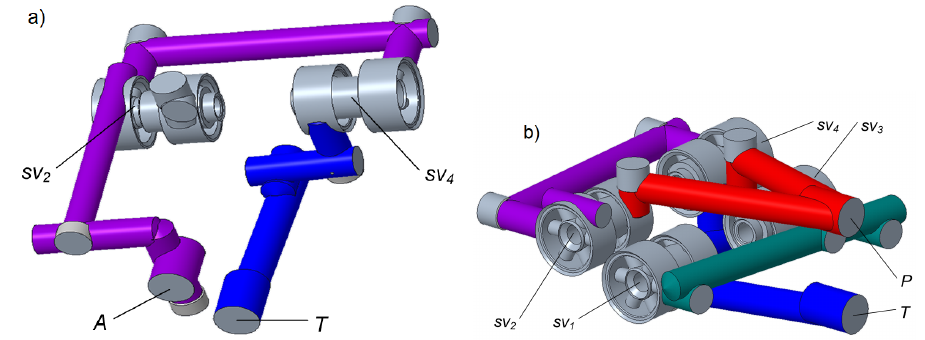
Figure 8. Fluid models of the flow lines: ( a ) A − T , ( b ) P − T ; sv 1 , . . . sv 4 —seat valves.